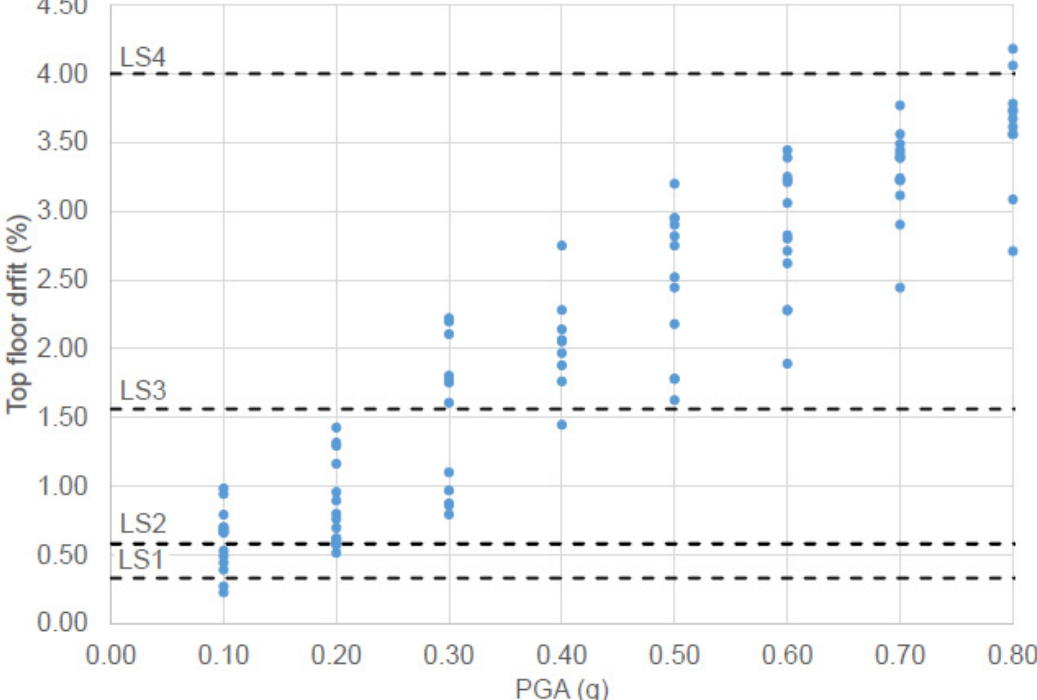
Figure 13. Structural results: relationships between PGA (g) and top-floor drifts (%).